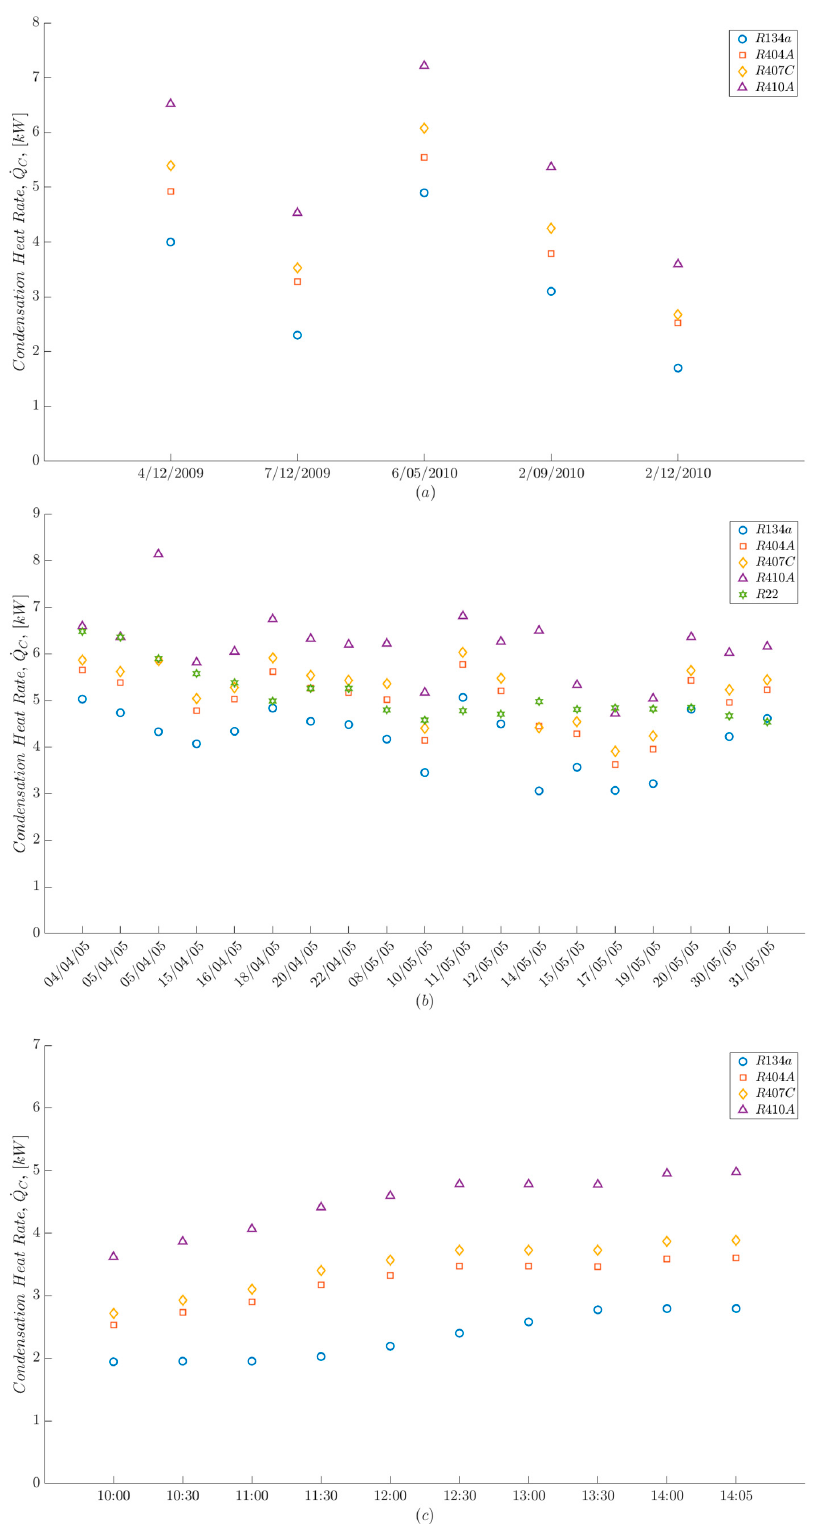
Figure 9. Condensation heat rate of the system with different refrigerants based on the optimization output ( a ) Madrid, ( b ) Shanghai, ( c ) Zagreb.